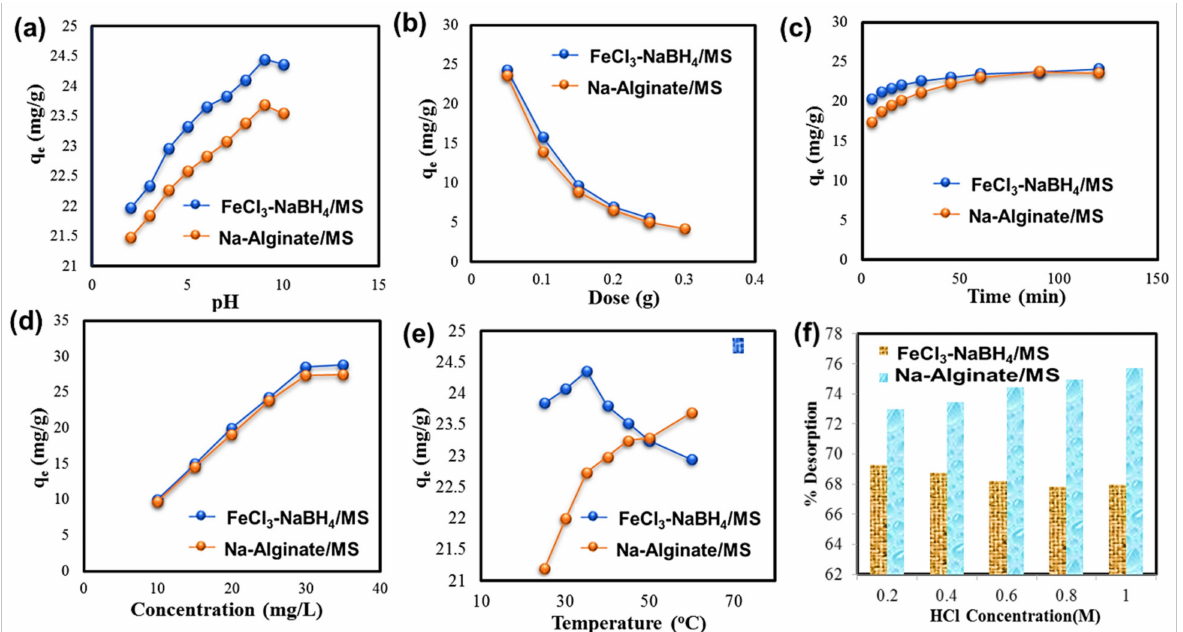
Figure 2. SEM micrographs of ( a ) FeCl 3 -NaBH 4 /MS hybrid composites and ( b ) Na-Alginate/MS composite beads.